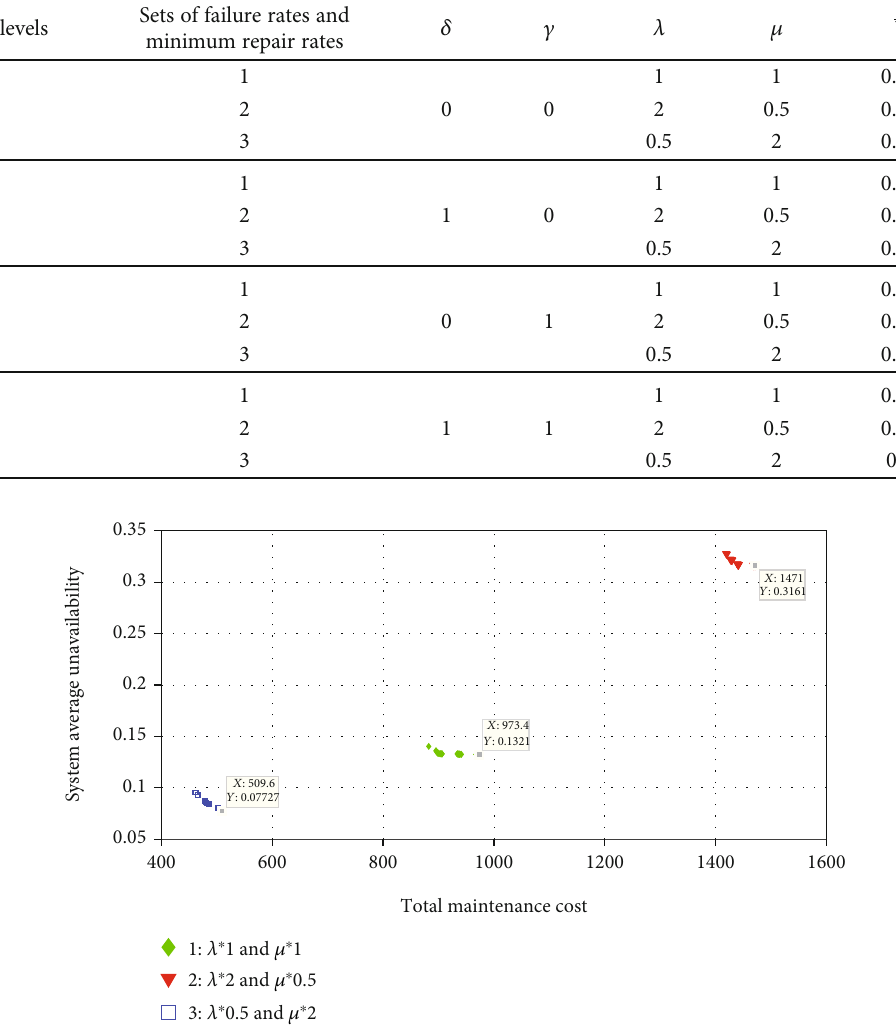
Figure 14: Pareto frontier for fi rst-level human